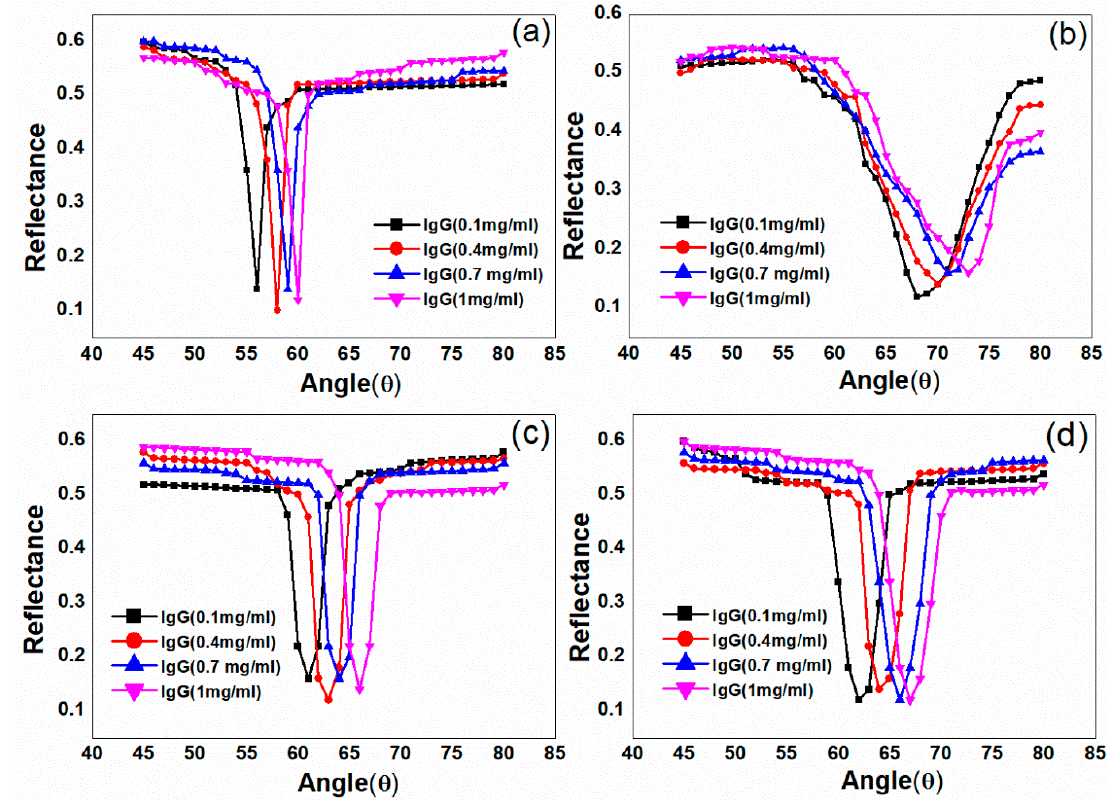
Figure 7. Reflectance vs. incident angle curve of the sensor ( a ) Ag-I, ( b ) Au-I, ( c ) Ag-Au-III, ( d ) Ag-Au-IV towards different concentrations of protein (0.1 mg/mL, 0.4 mg/mL, 0.7 mg/mL, and 1 mg/mL). Table 4. Experimentally Measured Values of FWHM and Shift in Resonance Angle due to Varied Concentrations of Test Protein.